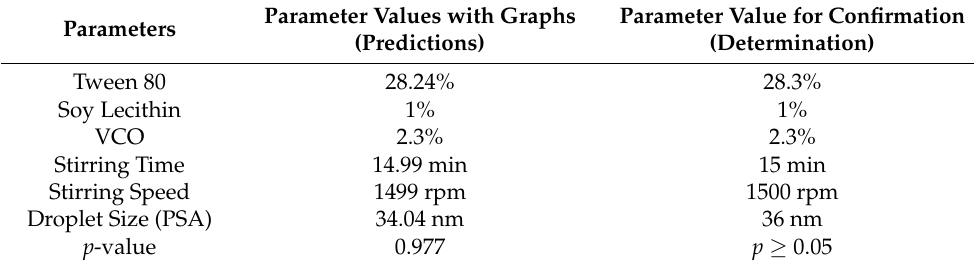
Figure 2. Useful plots for formula optimization: ( a ) overlay plot, ( b ) desirability plot, and ( c ) predic- tion plot according to lecithin and Tween-80 factors. Table 3. Confirmation of the predicted optimum